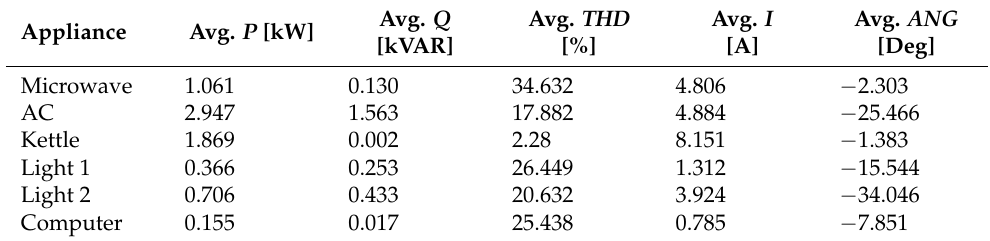
Table 3. Features Estimation for Devices (Private Dataset).